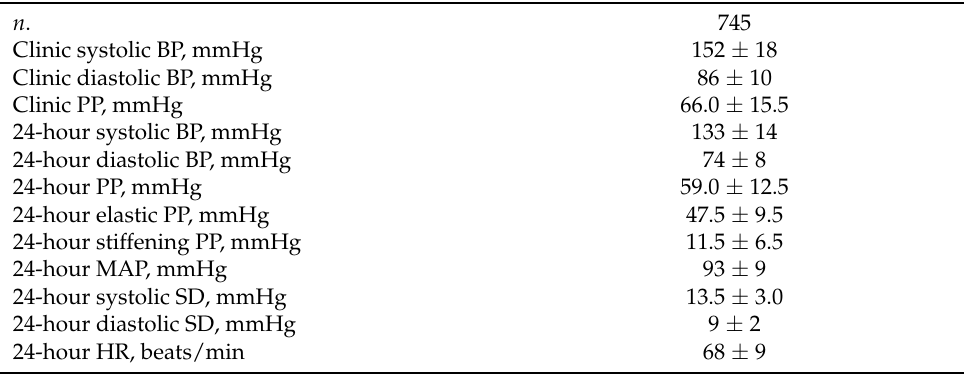
Table 2. Blood pressure and heart rate values of the study